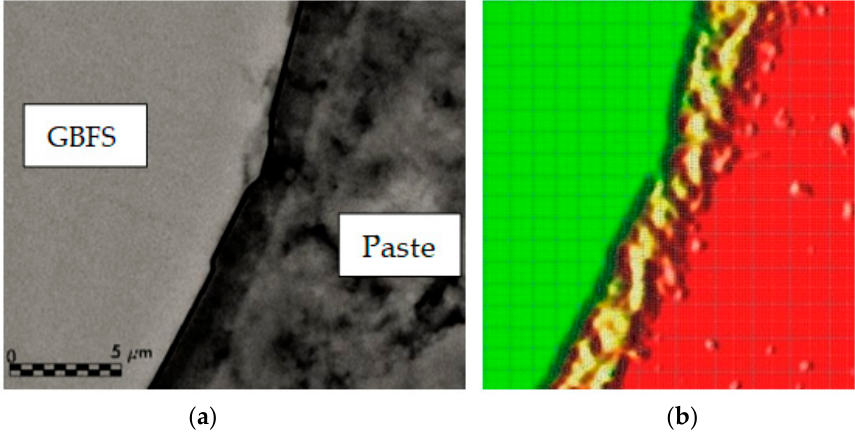
Figure 7. (a) Interface at 28 days; ( b ) representation of the mapping of Mg (band of 3 µm in yellow). Figure 7. ( a ) Interface at 28 days; ( b ) representation of the mapping of Mg (band of 3 µ m in